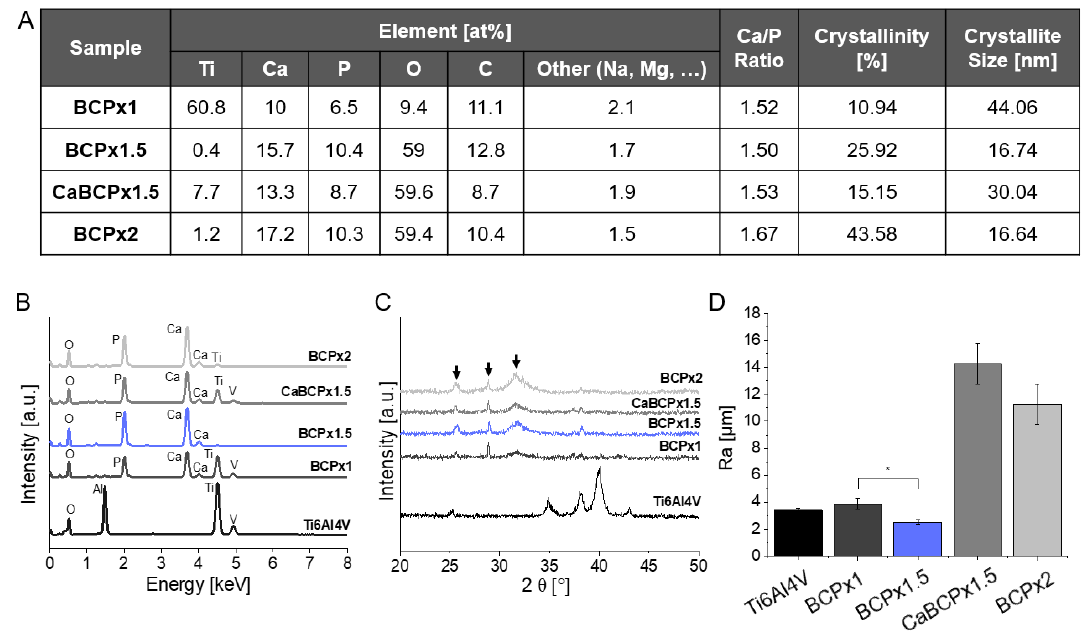
Figure 2. Analysis of biomimetic coatings precipitated on chemically pre-treated Ti6Al4V substrates after exposure to BCPx1, BCPx1.5 with and without CaCl 2 pre-treatment, and BCPx2 for 14 days. ( A ) Quantitative EDX elemental analysis, crystallinity, and crystallite sizes of examined surfaces. ( B ) Qualitative EDX elemental analysis. ( C ) XRD analysis. Arrows indicate HCA-related peak positions. ( D ) Arithmetic average roughness R a . The asterisks (*) indicate statistically significant differences using the Tukey test with a significance level of p < 0.05.